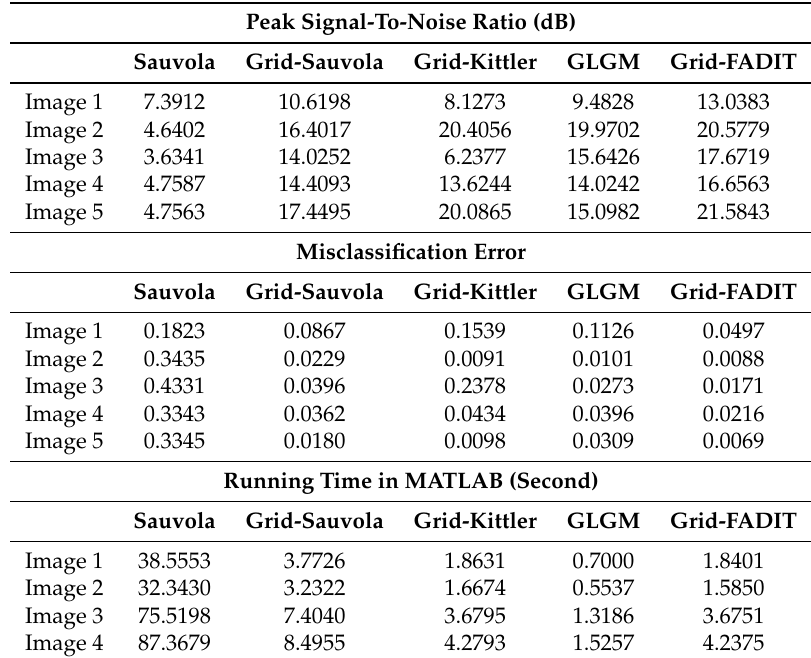
Table 3. Objective performance of different